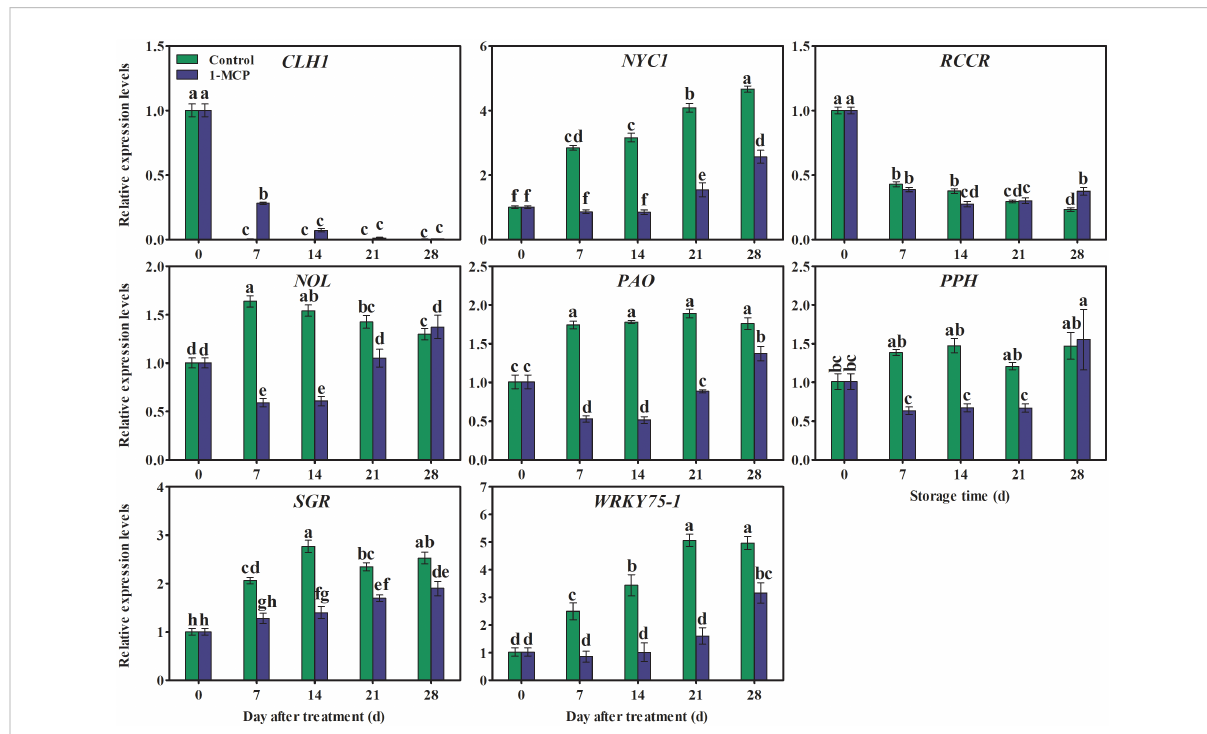
FIGURE 7 Effects of 1-MCP treatment on the expression pattern of genes associated with chlorophyll degradation in the peel of ‘ Yuluxiang ’ pear during storage. Data are mean ± SE ( n = 3); values labeled with different letters represent a signi fi cant difference at p